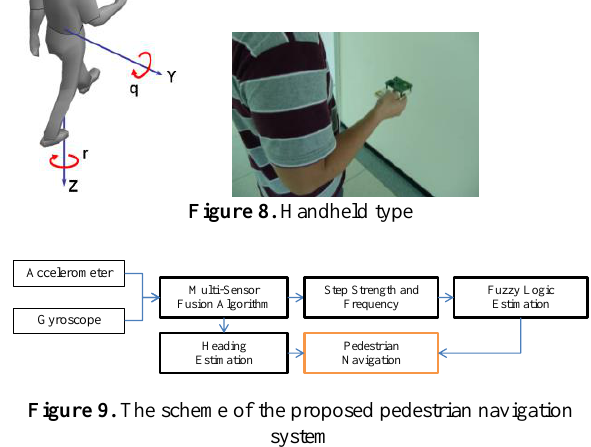
Figure 7. Waist-mounted type